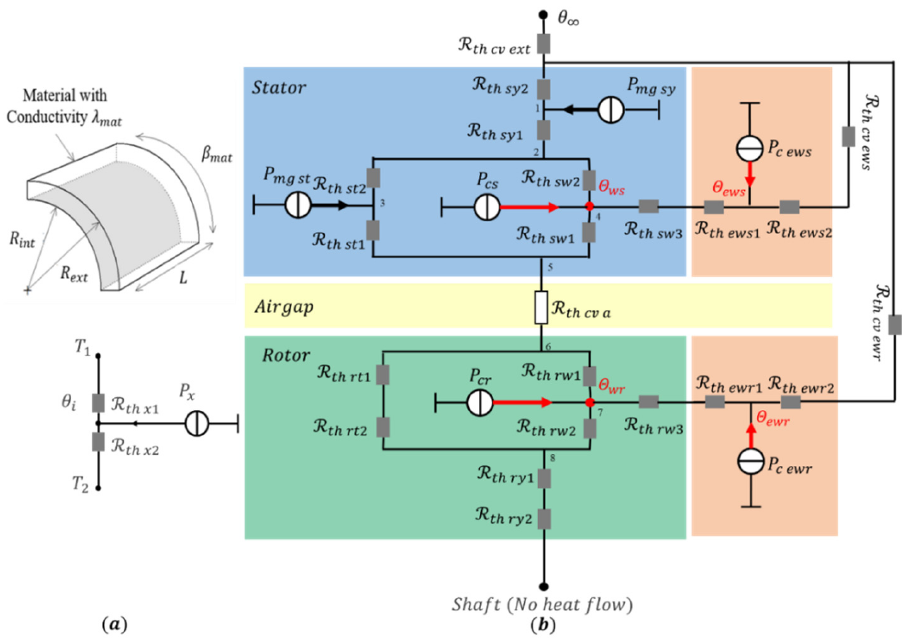
Figure 5. ( a ) Cylindrical element and its equivalent circuit, ( b ) Thermal equivalent circuit of the machine.